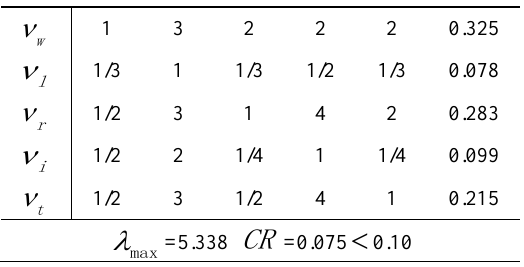
Table 2 Comparison matrix and indicator weights